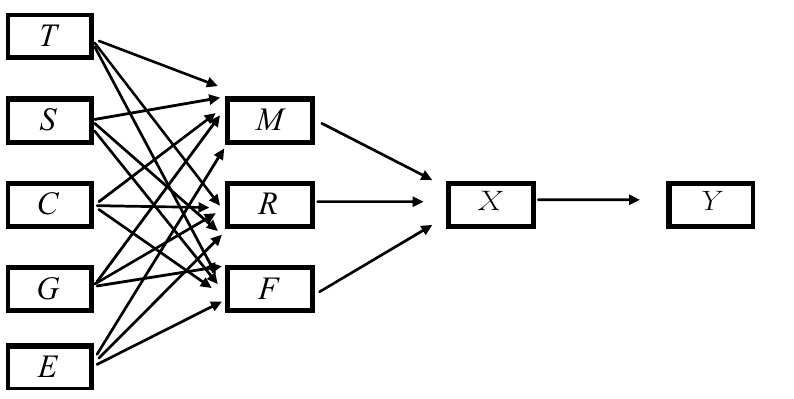
Figure 2 – Basic latent class Model